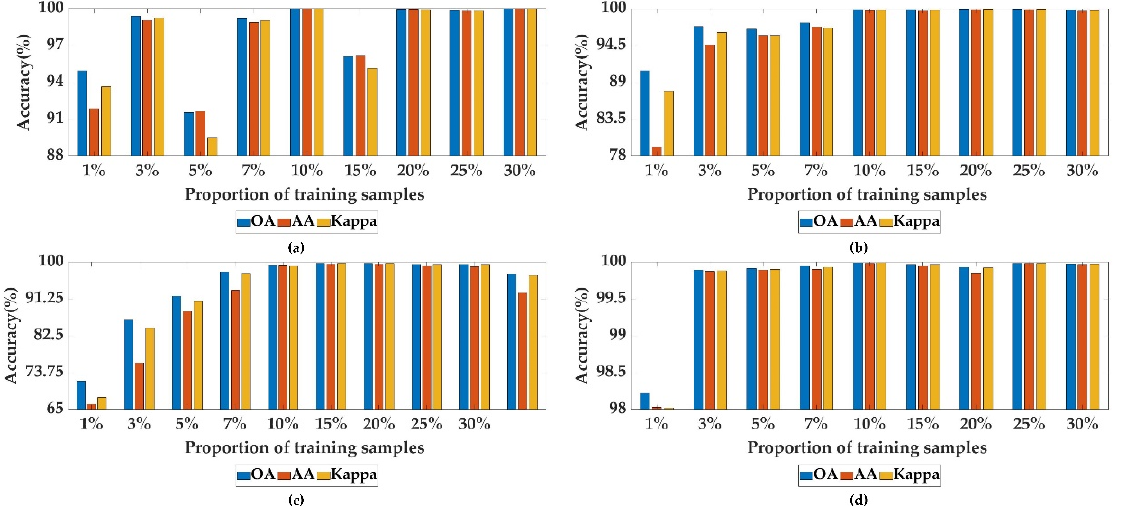
Figure 10. The classification results of different sample numbers. ( a ) on the SAC dataset, ( b ) on the UP dataset, ( c ) on the IP dataset, ( d ) on the SA dataset.